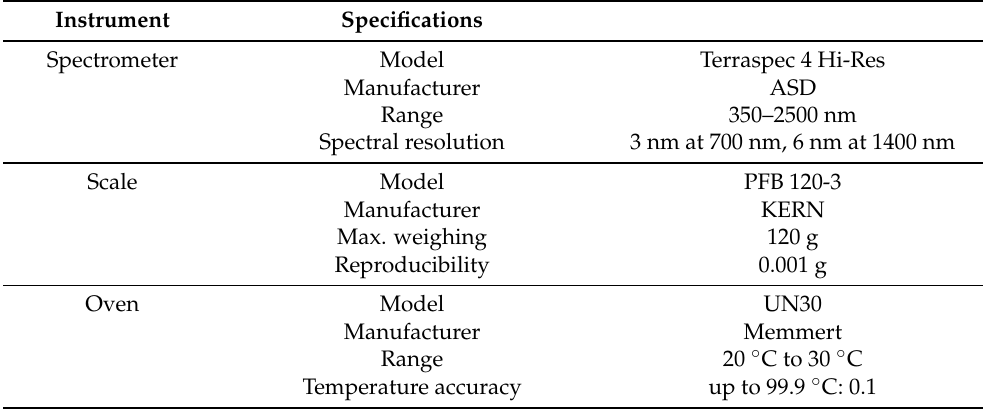
Table 1. Technical characteristics of the